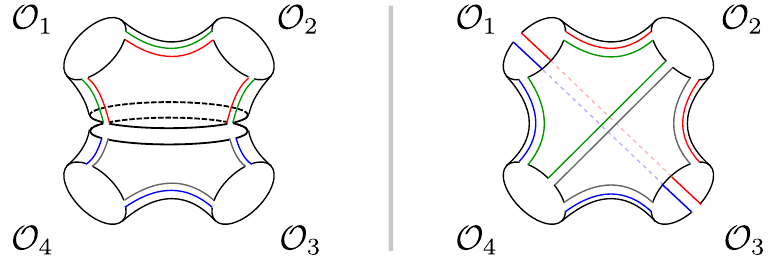
Figure 1 . We depict two ways of tessellating a four-point function by hexagonal patches. On the left, we (cid:12)rst cut it into two three-point functions, which can then be cut into hexagons; this corresponds to performing the operator product expansion (OPE), and it requires summing over intermediate physical states. On the right, we cut the four point-functions into four hexagons without introducing a sum over intermediate physical